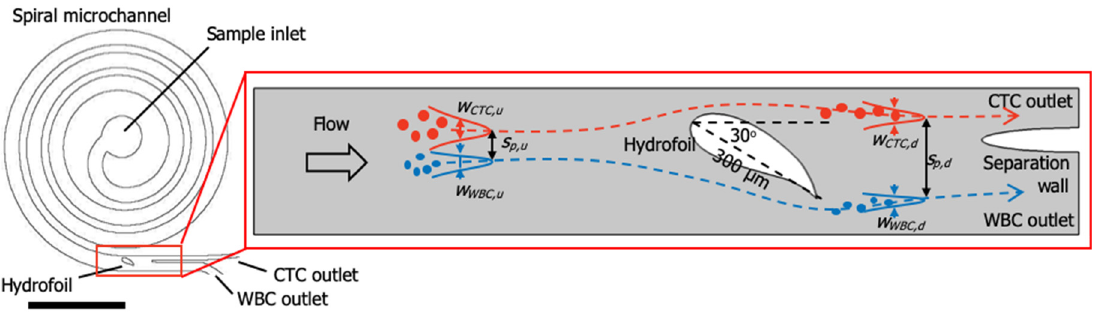
Figure 1. The hydrofoil located at the downstream of a spiral microchannel and the working principles of the hydrofoil. Circulating tumor cells (CTCs) (red dots) and white blood cells (WBCs) (blue dots) are pre-focused about their respective equilibrium positions separated at a distance of s p,u via a spiral channel at the upstream. The hydrofoil affects the stream, such as to increase the separation distance between the CTC and the WBC streams at the downstream to s p,d , which is large enough to direct the separated streams to CTC and WBC channels at the downstream separated by a separation wall. The length of the scale bar is 3 mm.